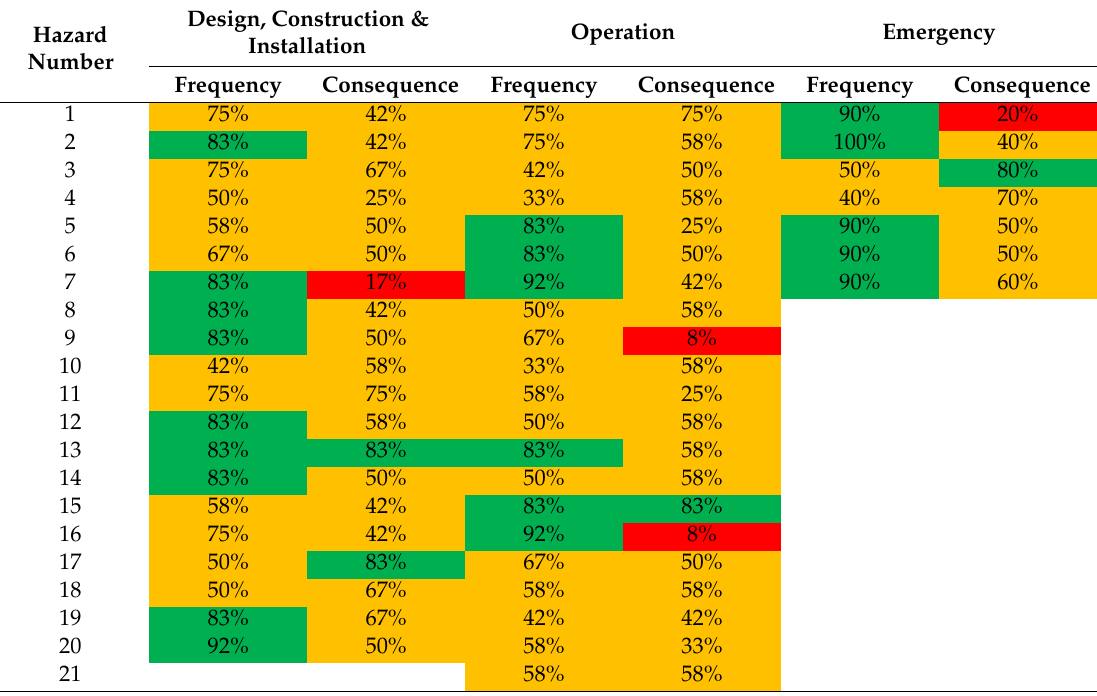
Table 10. Determination of data confidence levels (Three levels are colour coded as green / yellow / red, which presents strong / medium / low data